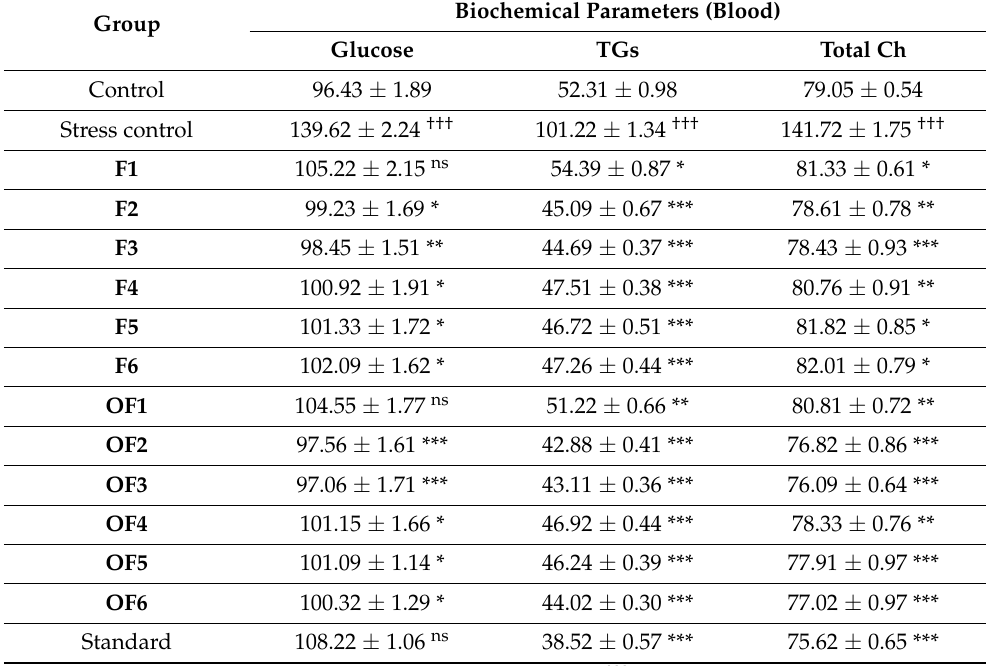
Table 4. Effect of flavonoids on different biochemical parameters in blood after restraint stress.